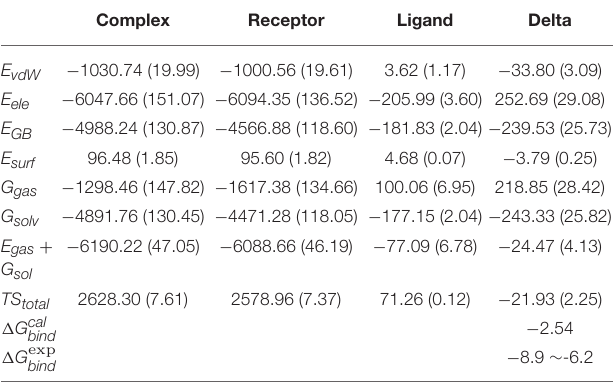
TABLE 1 | Binding free energy for tweezer/K214 complex and decomposition to electrostatic interaction, van der Walls interaction, solvation free energies, and